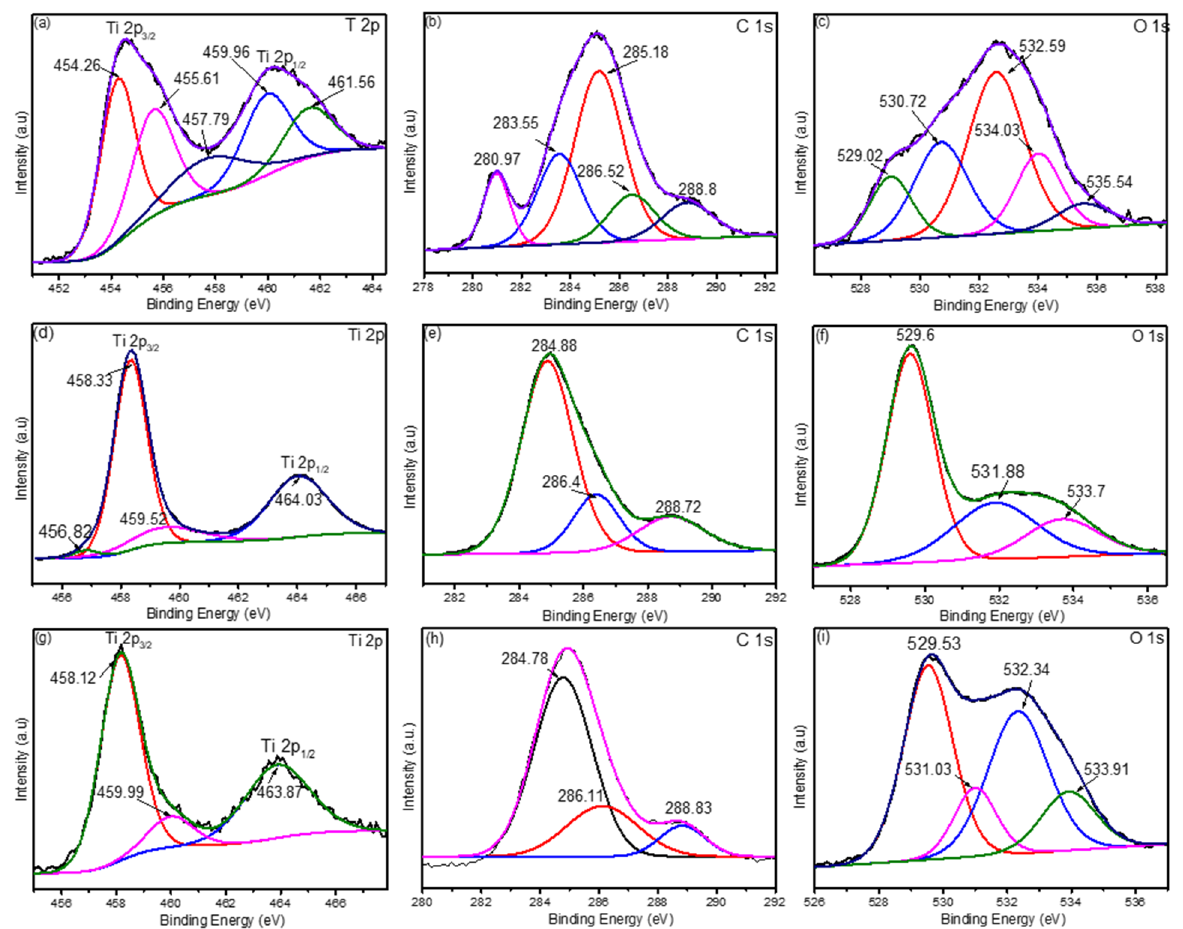
Figure 5. Ti 2p, C 1s, and O 1s high-resolution XPS spectra of Ti 3 C 2 ( a – c ), TiO 2 @Ti 3 C 2 ( d – f ), and Ag 3 PO 4 /TiO 2 @Ti 3 C 2 (A4) ( g – i ).